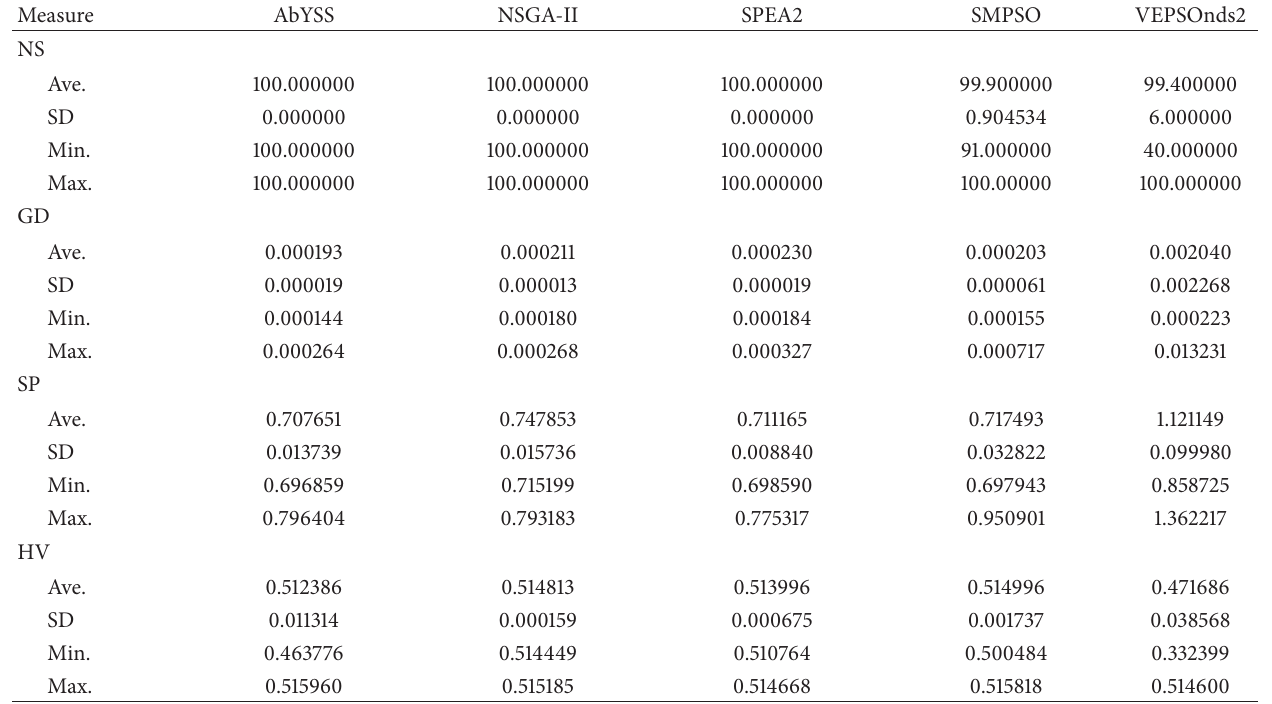
Table 8: Performance comparison based on ZDT3 test problem.